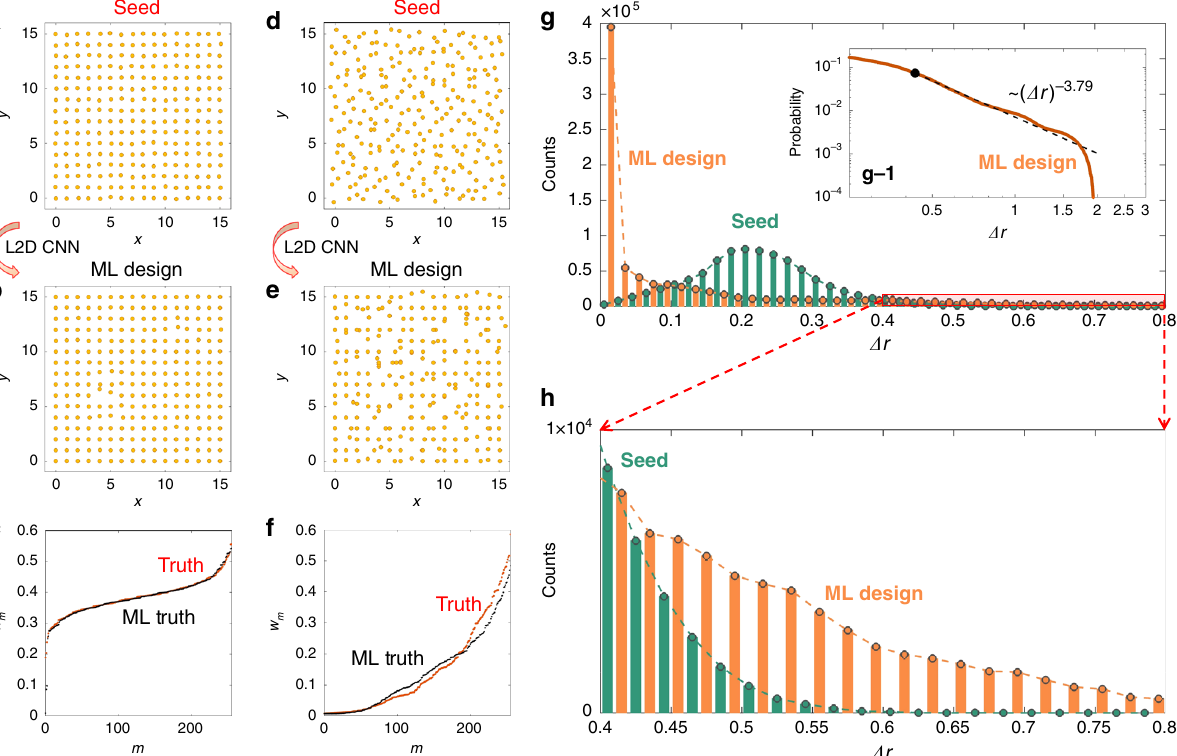
Fig. 4 Scale-invariant disordered structures generated by the localization-to-disorder convolutional neural network. a – f Comparison between seed and machine-learning- (ML-) generated structures for a – c weak and d – f strong disorder. a , d Seed structures that provide the target localizations for the localization-to-disorder (L2D) convolutional neural network (CNN). b , e ML-generated disordered structures obtained from the L2D CNN. c , f Localization of seed ( “ Truth ” , red dotted lines) and ML-generated ( “ ML Truth ” , black dotted lines) structures, obtained from the tight-binding Hamiltonian in Eq. (1). g Statistical distributions of the strength of the lattice deformation Δ r in the seed (green) and ML-generated (orange) structures for 3200 realizations satisfying 0.20 ≤ w avg ≤ 0.30 in the ML design. The fi rst inset g-1 shows the log – log plot of g for the ML design, illustrating the power-law distribution. The orange line (composed of discretized points) represents the complementary cumulative distribution function (CDF) obtained from the data set in g . The black dashed line represents the best fi t to the data using the method in refs. 50,51 , showing the power-law fi tting of ( Δ r ) − 3.79 . The black dot represents the lower bound Δ r min = 0.432 to the power-law behavior. h The extended plot of the range 0.4 ≤ Δ r ≤ 0.8 in g demonstrating the heavy-tailed distribution of the ML